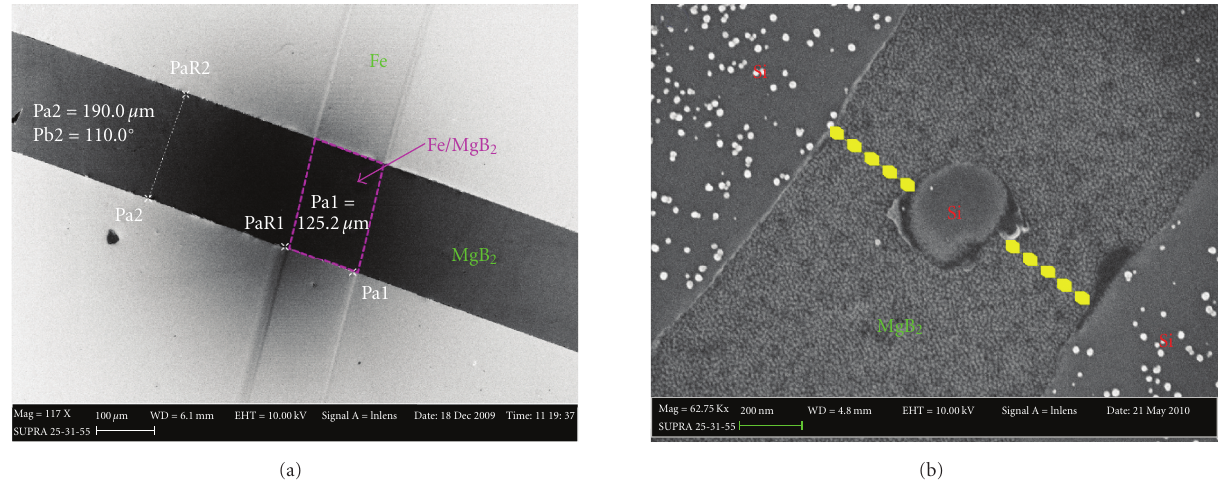
Figure 11: Scanning electron microscopy images of possible thin film MgB 2 devices: (a) weak link created by Fe proximity e ff ect; (b) superconducting quantum interference device geometry, where the two yellow dashed lines would be Josephson